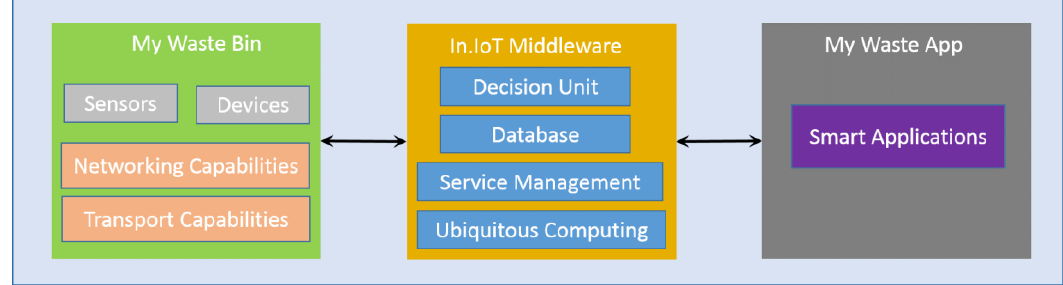
Figure 2. Illustration of the system architecture.